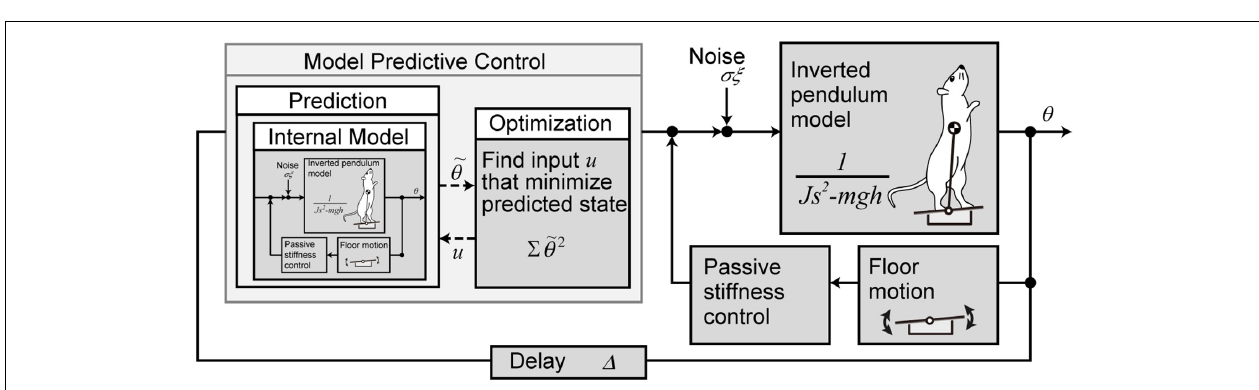
FIGURE 1 | Experimental methods. (A) Experimental apparatus. (B) Paradigm of the floor tilting trial. (C) A rat maintaining upright posture and rotation direction of the floor. (D) Definition of body segments. (E) Definitions of center-of-mass angle and segment angles.